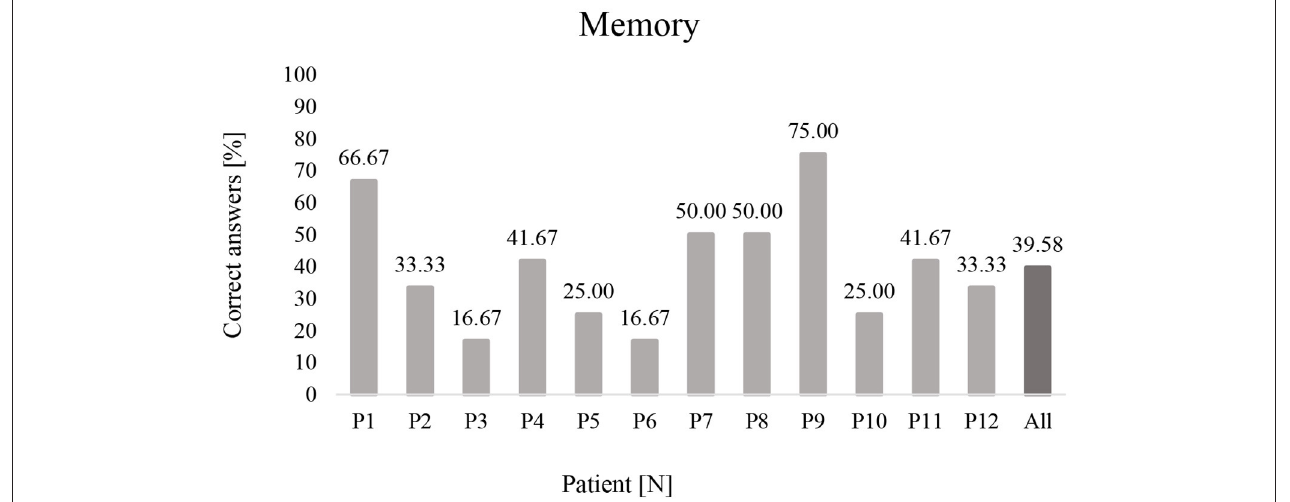
FIGURE 2 | Percentage of correct answers made by patients from memory tasks (P1-P12). P, Patient.